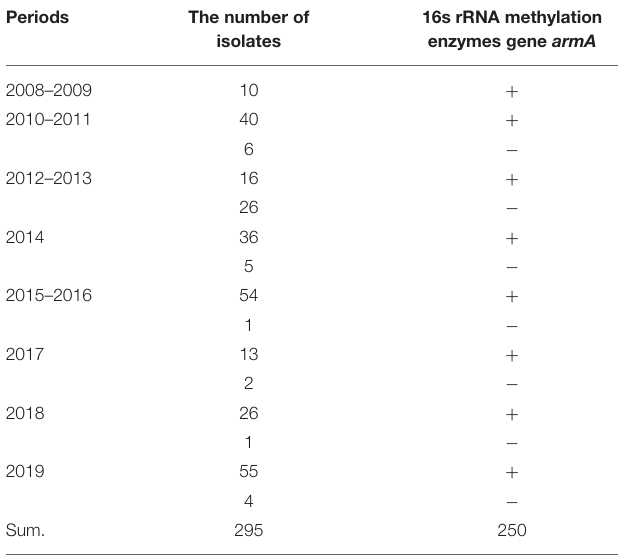
TABLE 5 | The profiles of the 16s rRNA methylation enzymes gene of 295 MDR A. baumannii isolates . Periods The number of